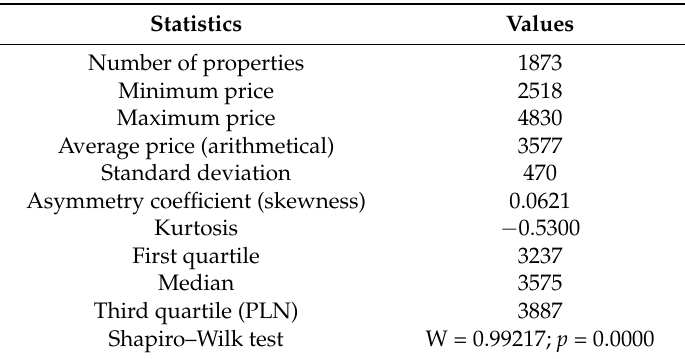
Table 1. Descriptive statistics for selling price *